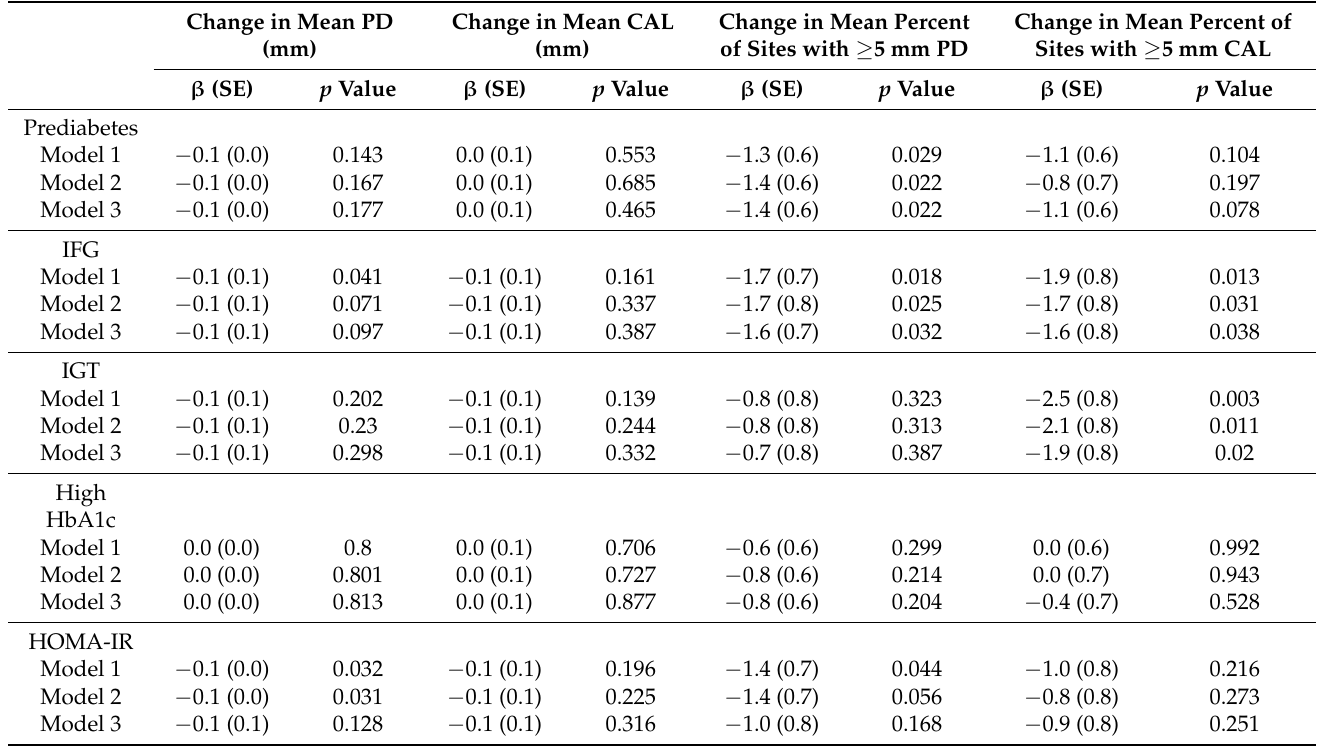
Table 4. Results from multivariable linear regression models for the relationship between glucose metabolism measures and three-year changes in